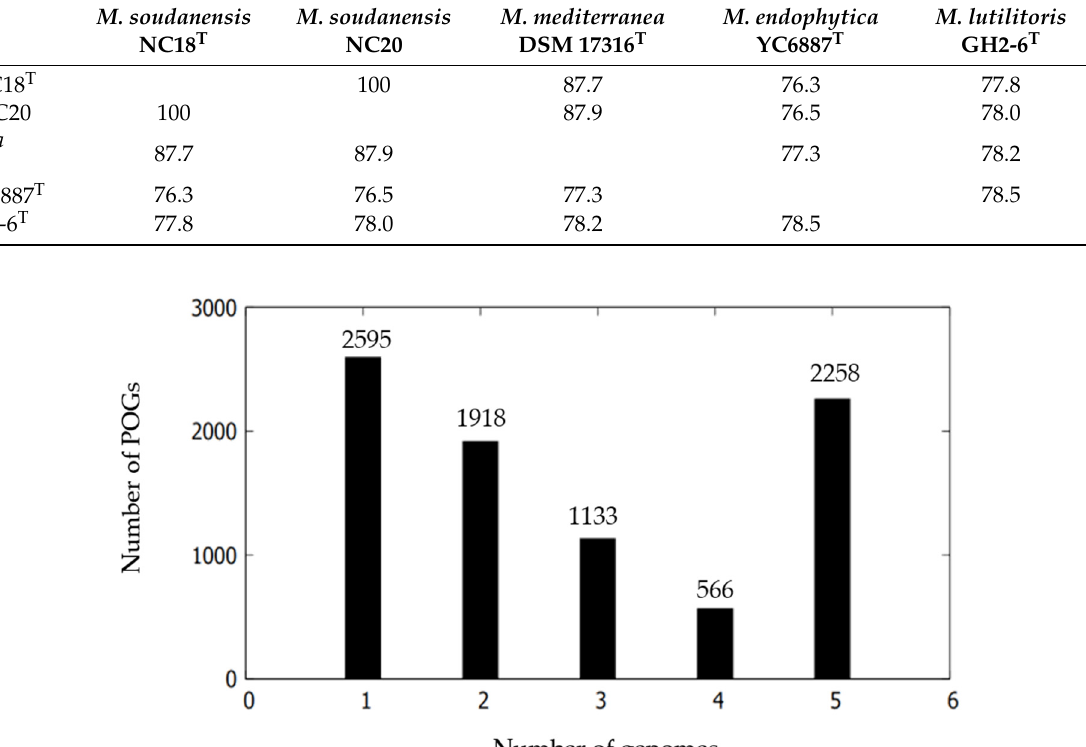
Figure 3. Comparison of POG distribution of strains NC18 T and NC20 with related taxa within the genus Martelella .